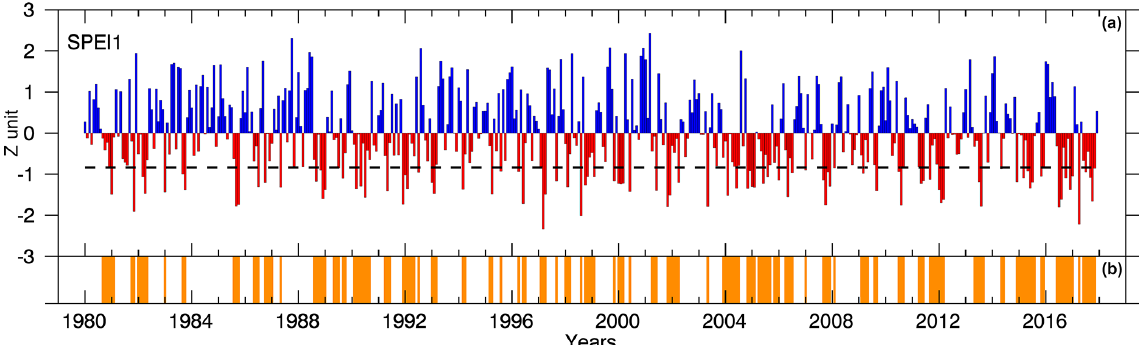
Figure 5. Wet (blue bars) and dry (red bars) conditions in the MLSHD according to the (a) SPEI1 and (b) dry episodes (orange bars) during